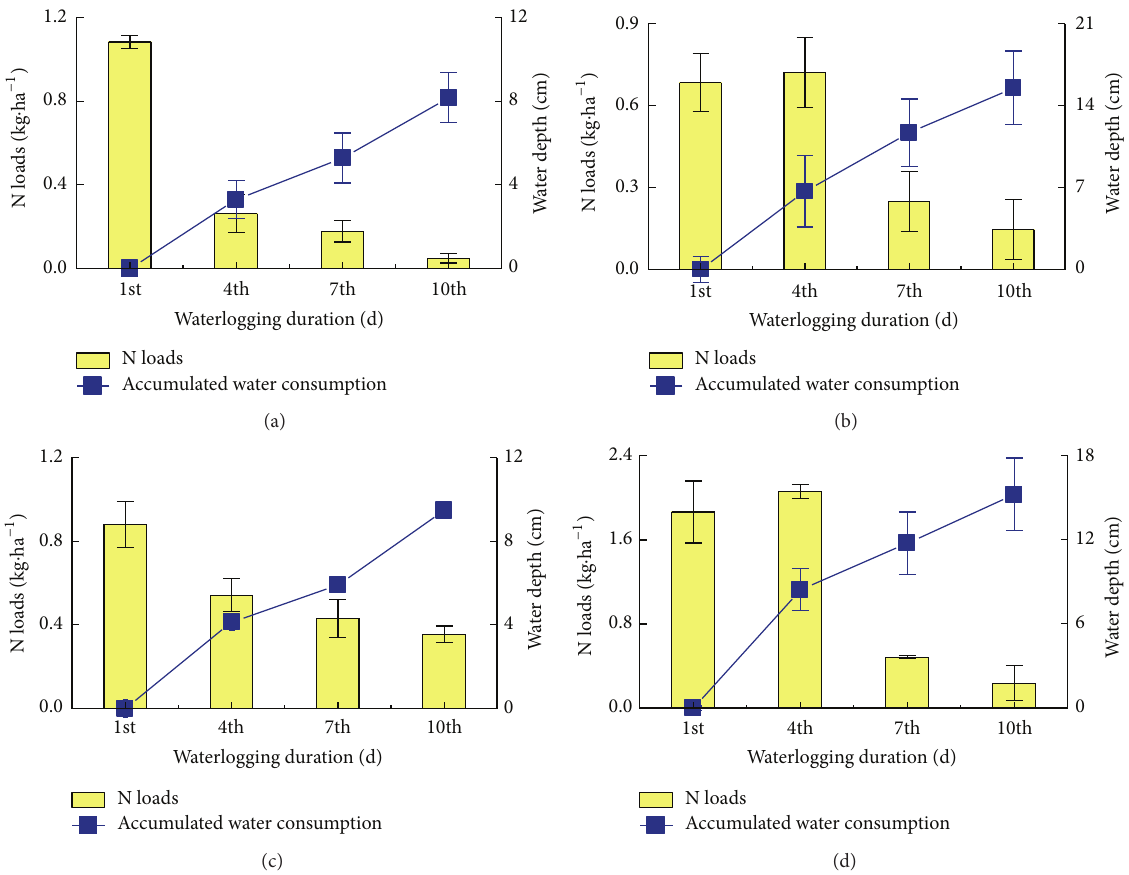
Figure 4: Loads of N in surface water and accumulated water consumption. (a) Tillering stage. (b) Jointing-booting stage. (c) Heading- flowering stage. (d) Milking stage. The accumulated water consumption was measured by water decrease depth.